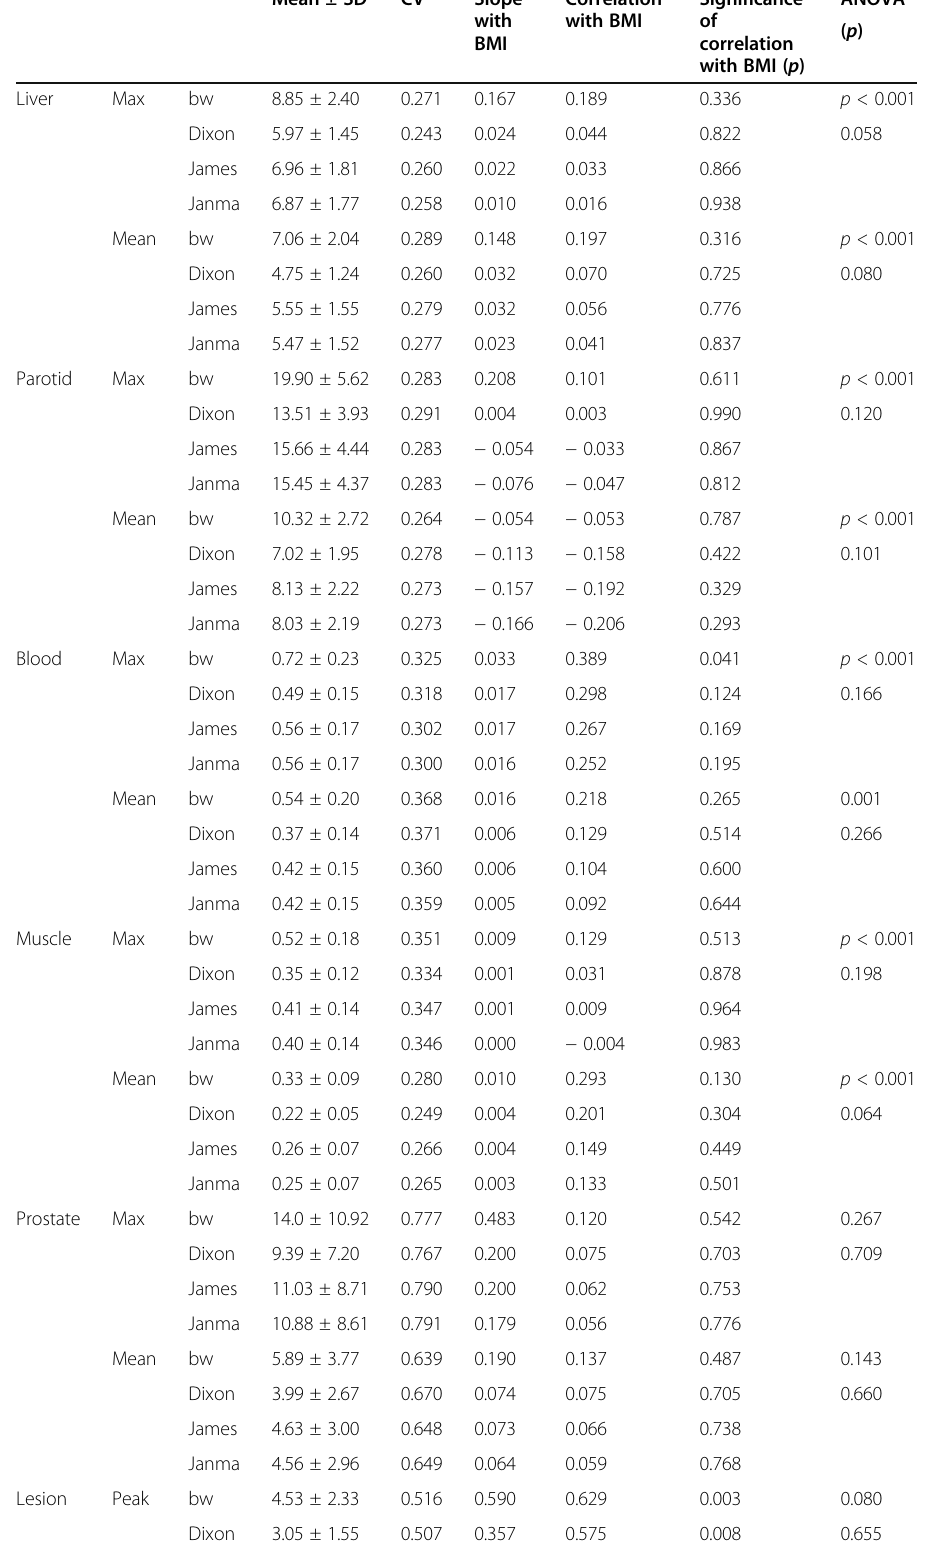
Table 4 Fitting results and dependent analysis of SUV vs BMI for the PSMA study ( n =